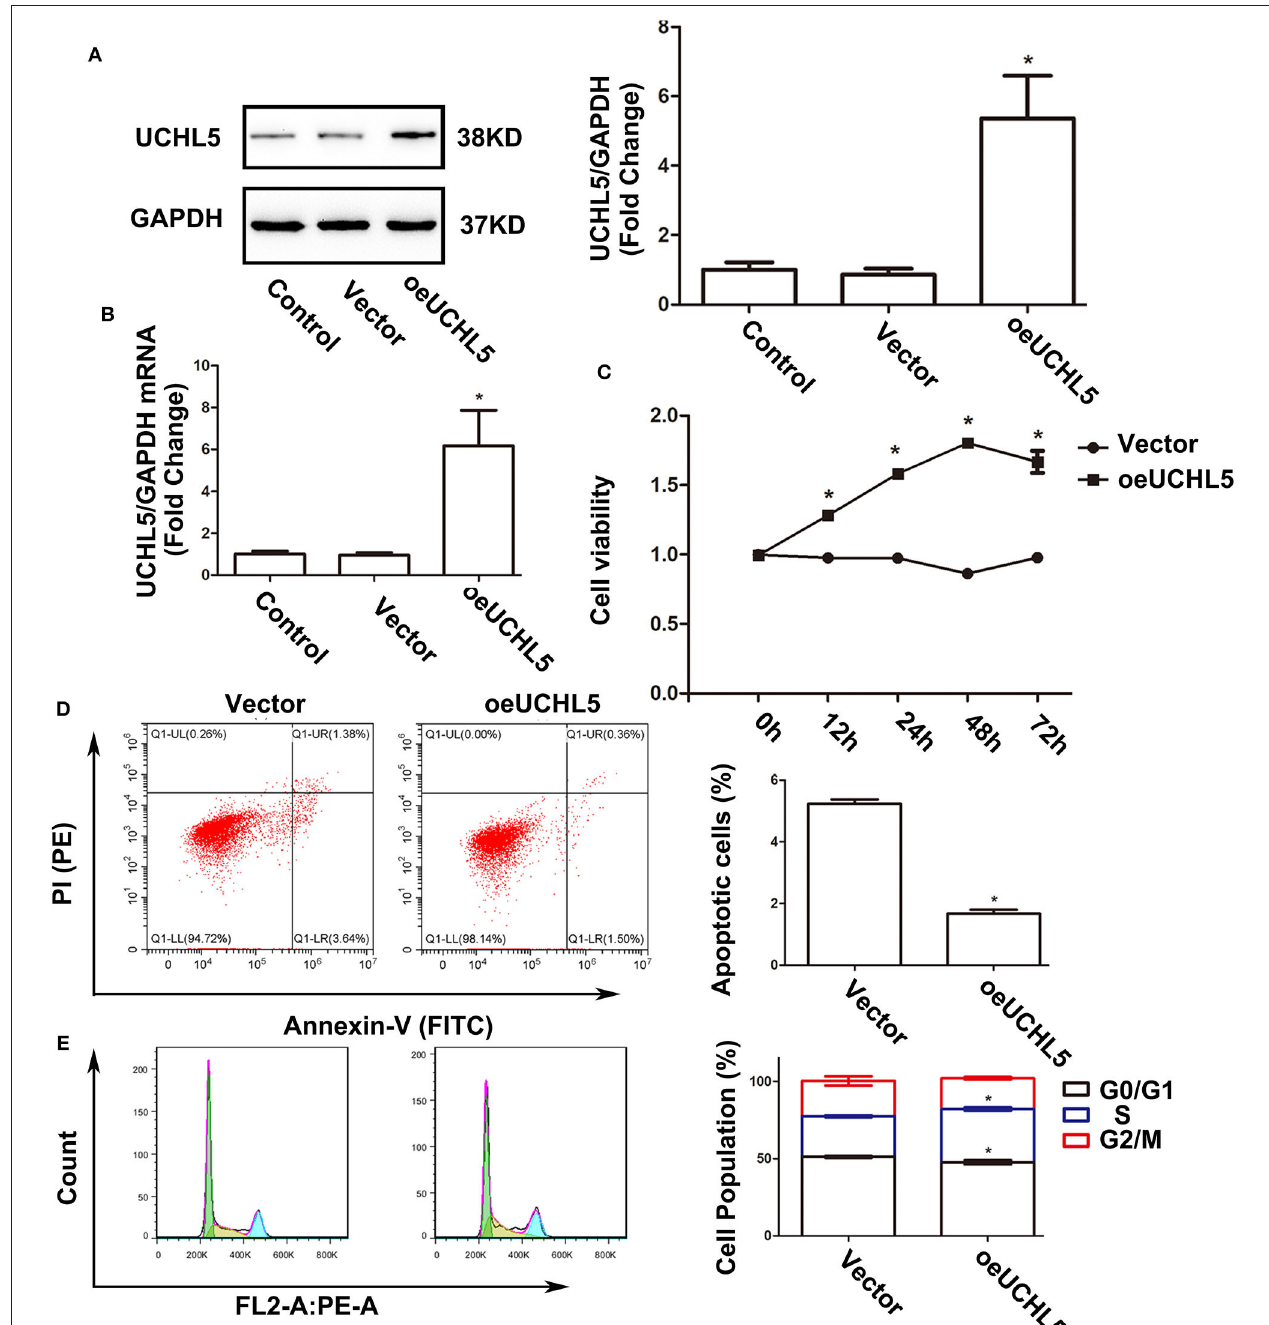
FIGURE 4 | Upregulation of UCHL5 promoted cell viability, attenuated apoptosis, and accelerated cell cycle in AN3-CA cells. (A) The levels of UCHL5 were detected by WB in AN3-CA cells at 48h after being infected with overexpressed lentiviral vectors ( N = 3 times). * P < 0.05 vs. control. (B) Relative mRNA levels of UCHL5 measured by qRT-PCR in overexpressed lentiviral infected AN3-CA cells ( N = 3). * P < 0.05 vs. control. (C) Relative cell viability was detected by CCK-8 at different time points ( N = 3). * P < 0.05 vs. oeUCHL5 group. (D) Apoptosis cells were marked by Annexin V-FITC/PI, and the percentage was analyzed by flow cytometry ( N ≥ 3). * P < 0.05 vs. empty vector. (E) Cell cycle was measured by Cell Cycle Analysis Kit ( N ≥ 3). * P < 0.05 vs. empty vector.